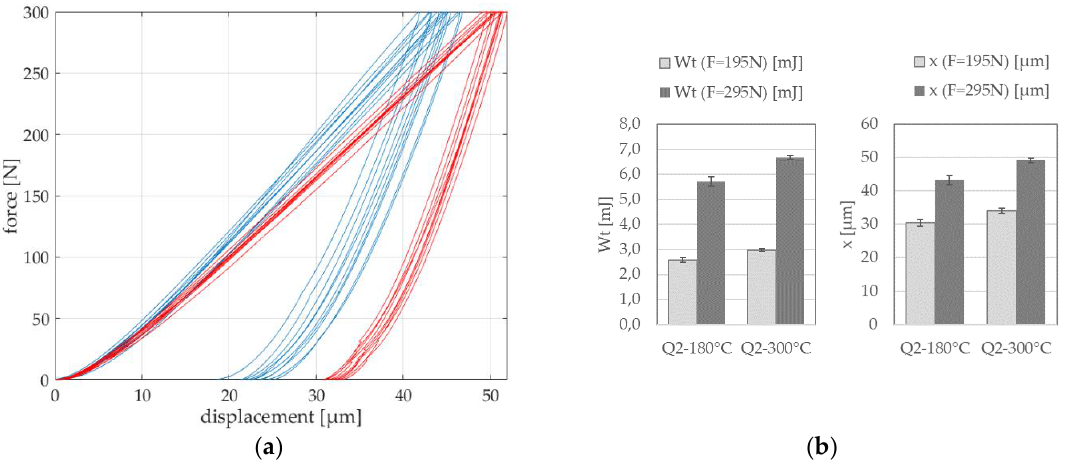
Figure 5. Extracting descriptors from micro compression tests on spherical samples: ( a ) Force- displacement curves of heat treatment conditions Q2-180 °C (blue) and Q2-300 °C (red); ( b ) exemplary evaluation of the mechanical work W t and the displacement x each at loads of 195 and 295 N.